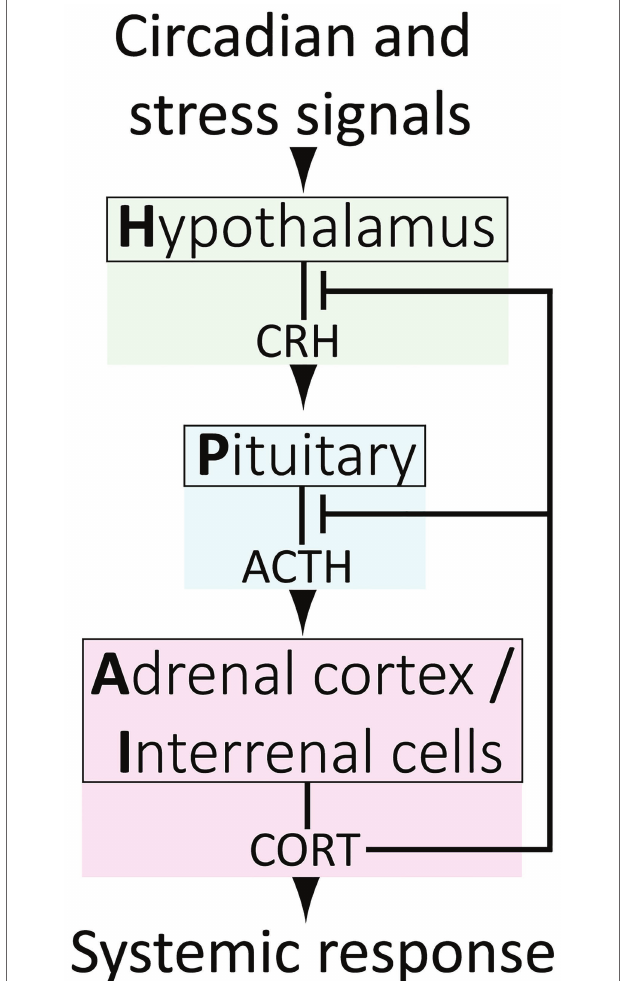
FIGURE 1 | The vertebrate Hypothalamus-Pituitary–Adrenal/Interrenal (HPA/I)